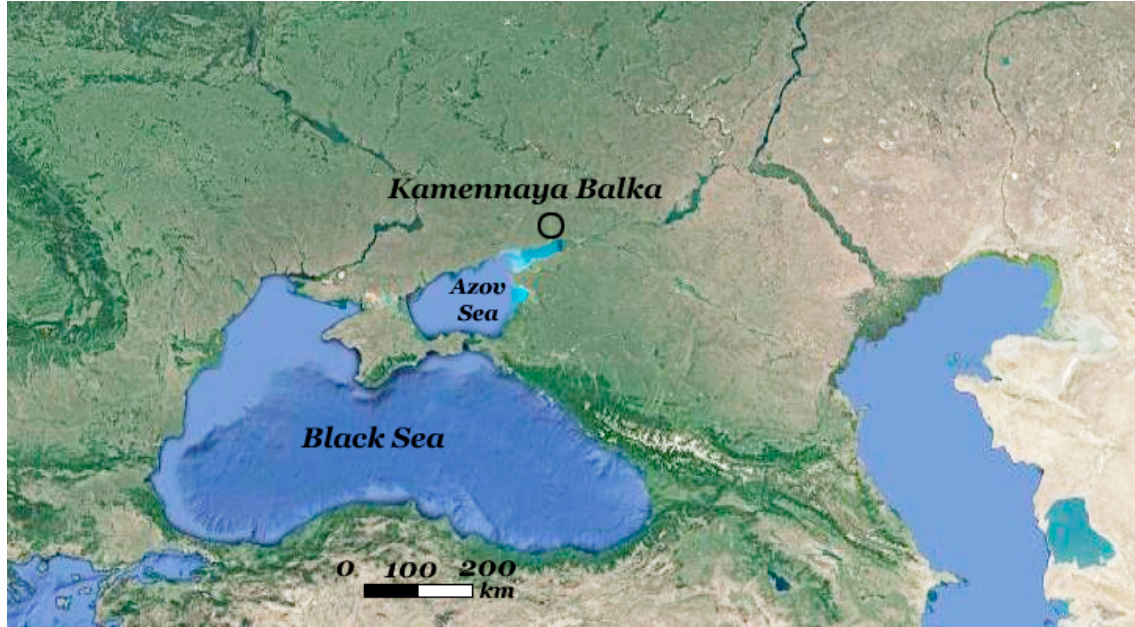
Figure 1. Location of the Kamennaya Balka Paleolithic sites complex.